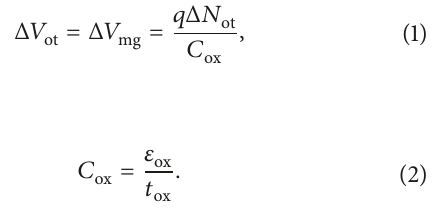
measured at biases and times compared to those used